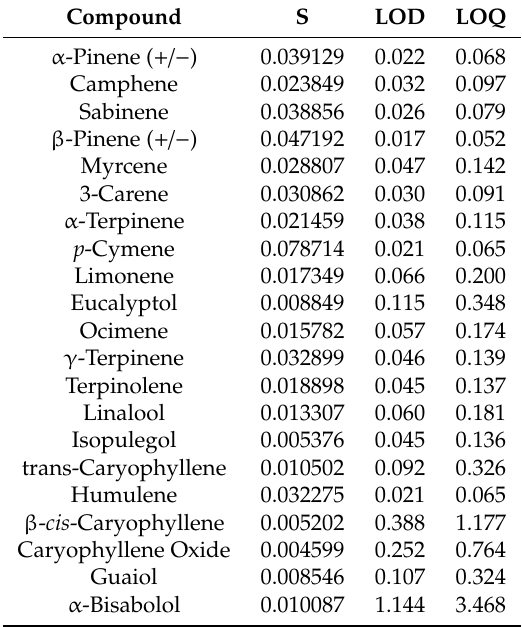
Table 2. Detection (LOD) and quantitation (LOQ) limits in µ g / mL for the validation compounds. Compounds are listed in order of their retention times. S: slope of calibration curve.